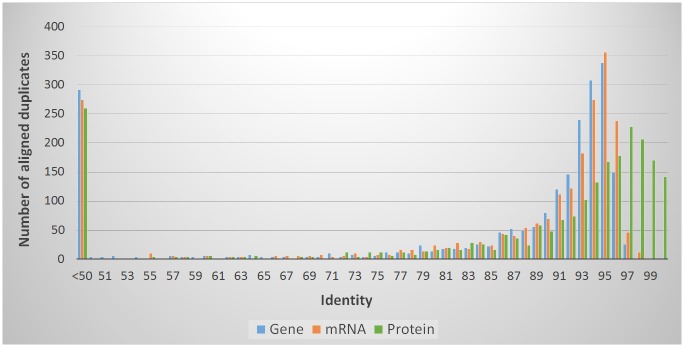
Identity values of D. rosae paralogs.Histogram of identity scores generated by global alignment of all duplicated BUSCO orthologs in the D. rosae assembly. The gene alignments include intron sequences.